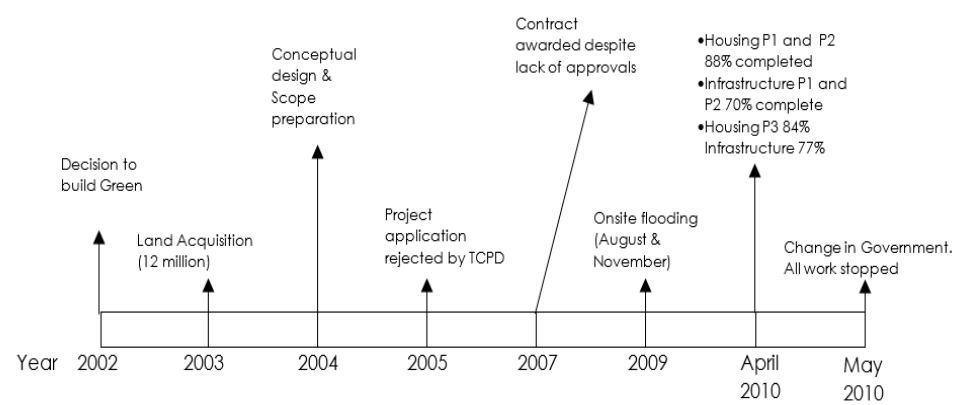
Figure 1. Timeline 1 for Greenvale (project level) during the period 2002–2010.